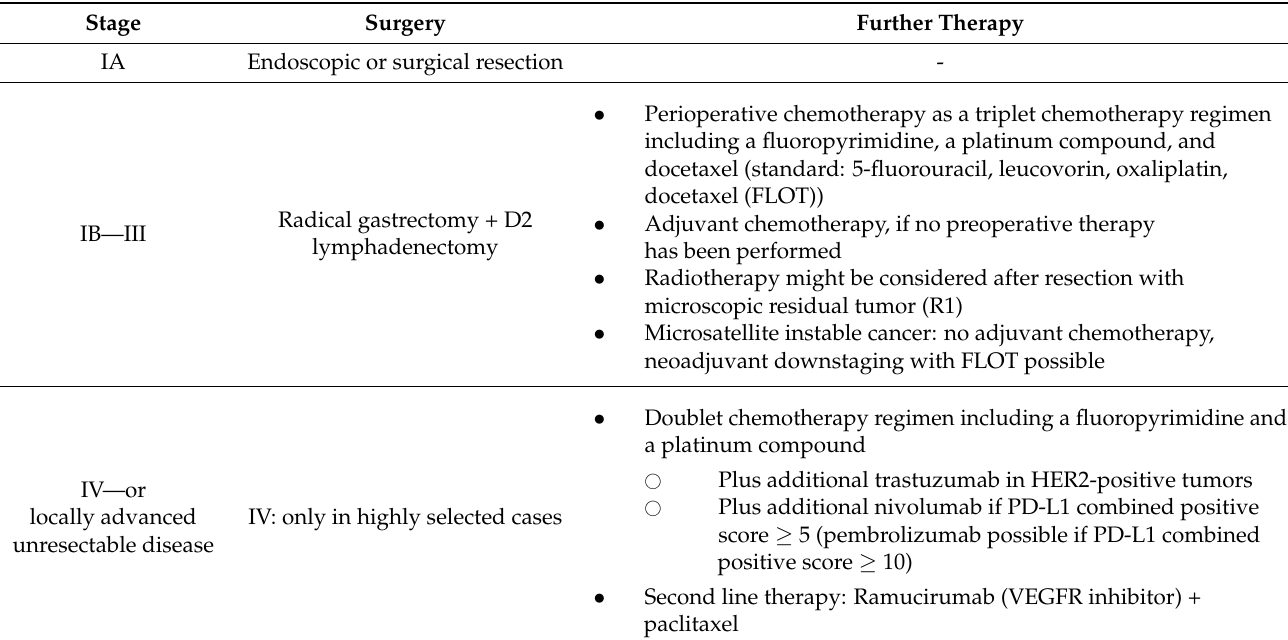
Table 5. Treatment algorithm for gastric carcinoma, simplified illustration, based on the guidelines of the European Society for Medical Oncology [23] (Staging: as shown in Supplemental Material Table S2).